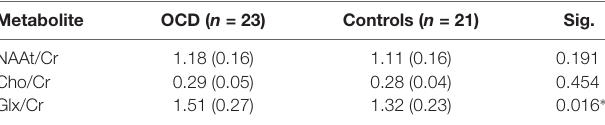
TABLE 2 | Comparison between metabolites’ concentration in OCD vs. healthy controls in anterior cingulate cortex (ACC). Metabolite